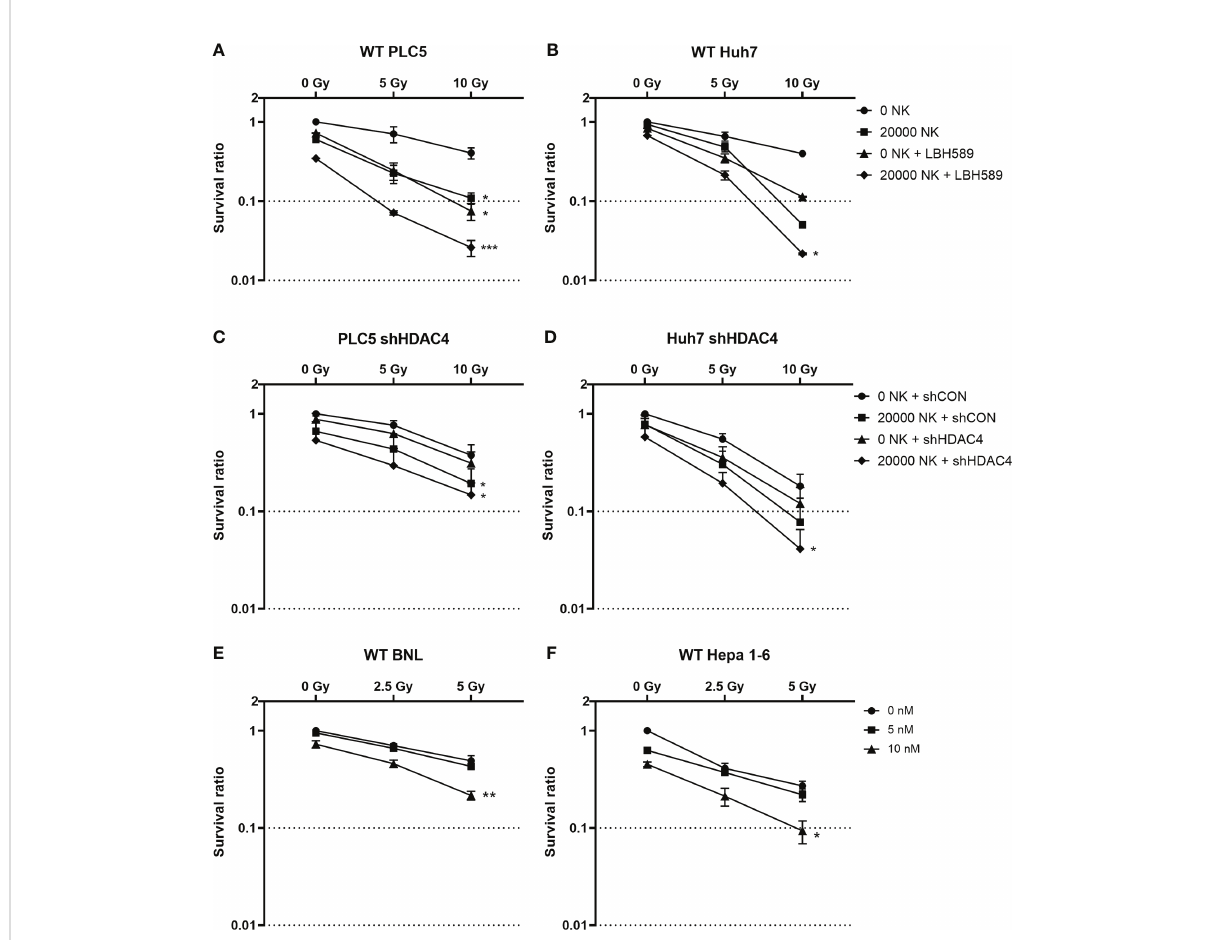
FIGURE 1 Effect of HDAC inhibition and radiotherapy on clonogenic survival in HCC cells co-cultured with or without natural killer (NK) cells. (A) Wild-type PLC5 cells and (B) Huh7 cells irradiated with 0, 5 Gy, 10Gy and/or treated with 10 nM of panobinostat (LBH589), a pan-HDAC inhibitor were co- cultured with 0 or 20000 NK cells; (C) HDAC4 knockdown (shHDAC4) PLC5 cells and (D) Huh7 cells as well as the corresponding shRNA vector- control cells (shCON) irradiated with 0, 5 Gy, 10 Gy were co-cultured with 0 or 20000 NK cells; (E) Wild-type BNL cells and (F) Hepa 1-6 cells were treated with various doses (0, 5 nM, 10 nM) of HDACi. Signi fi cant synergistic effects were observed with combined HDACi or HDAC4 knockdown and radiotherapy on decreased cell survival and enhanced NK cell-related cytotoxicity in HCC cells. Error bars indicate SD, * P < 0.05, **p < 0.01, ***p <